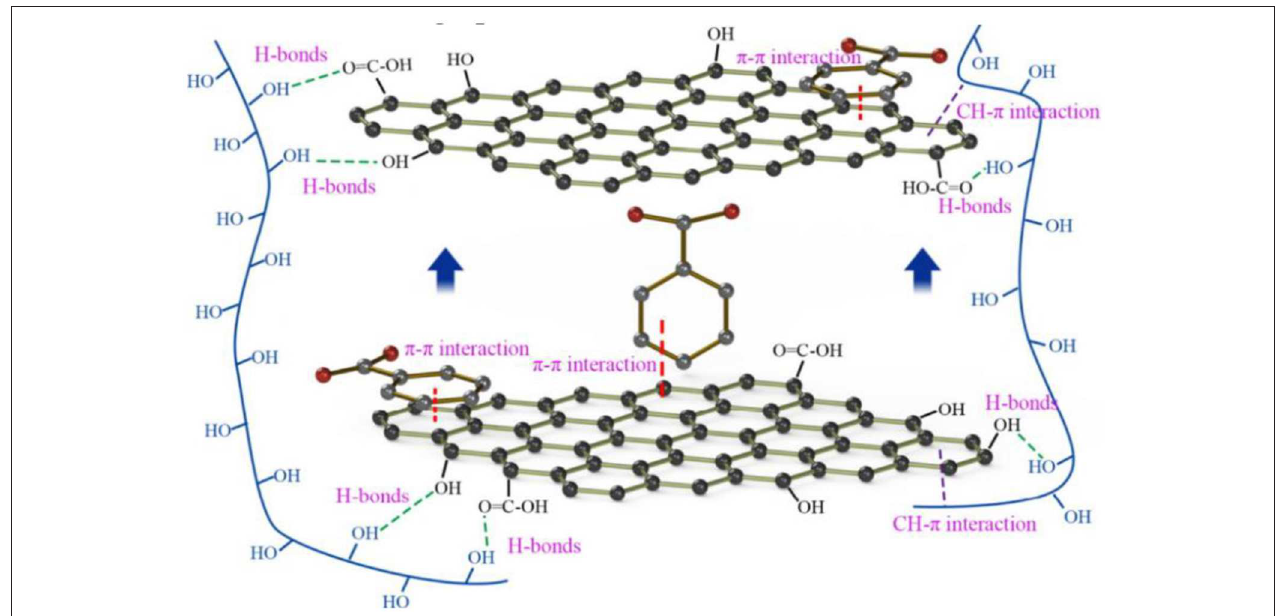
FIGURE 5 | Schematic diagram of the interaction among the reduced graphene oxide (rGO) sheets, poly(vinyl alcohol) molecules, and poly(sodium 4-styrenesulfonate) molecules ( Wang X. D. et al.,